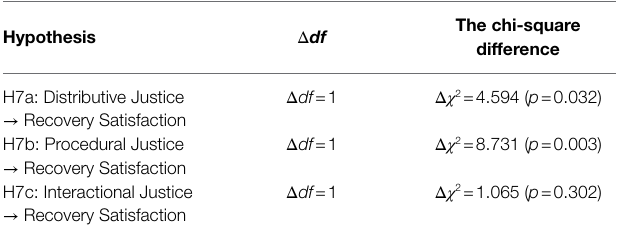
TABLE 5 | Analysis results of the moderating role of emotional attachment. Hypothesis Δ df